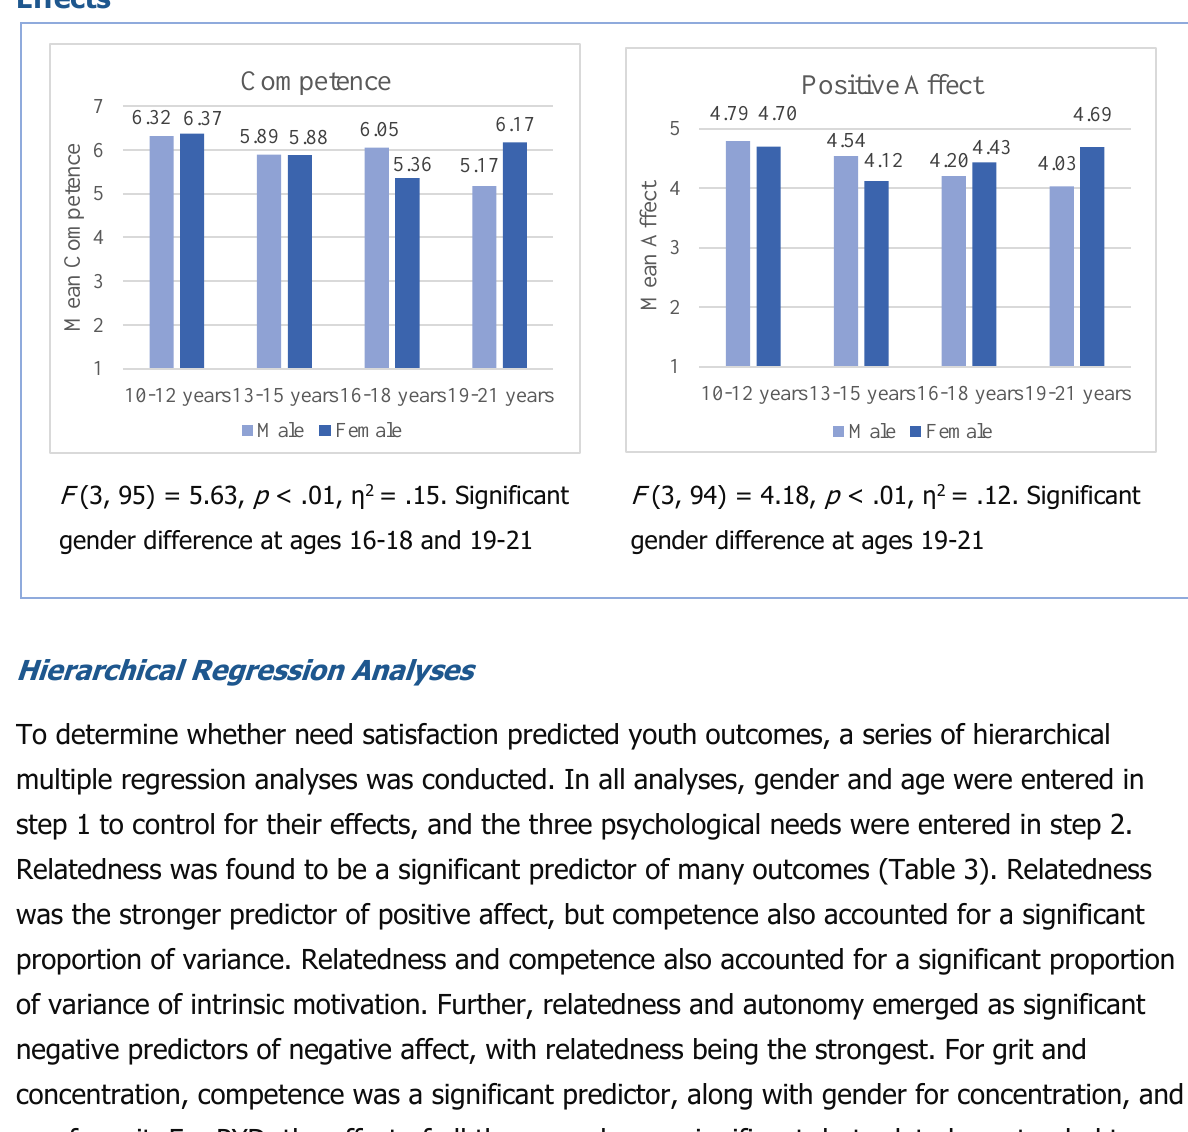
Figure 1. Gender and Age Differences in Youth Development Outcomes: Interaction